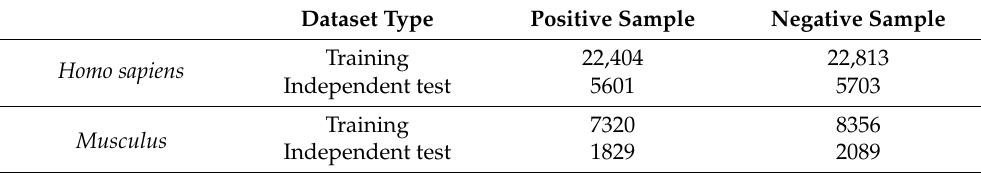
Table 7. Dataset information of Homo sapiens and Musculus , where the threshold of CD-HIT is 0.9.